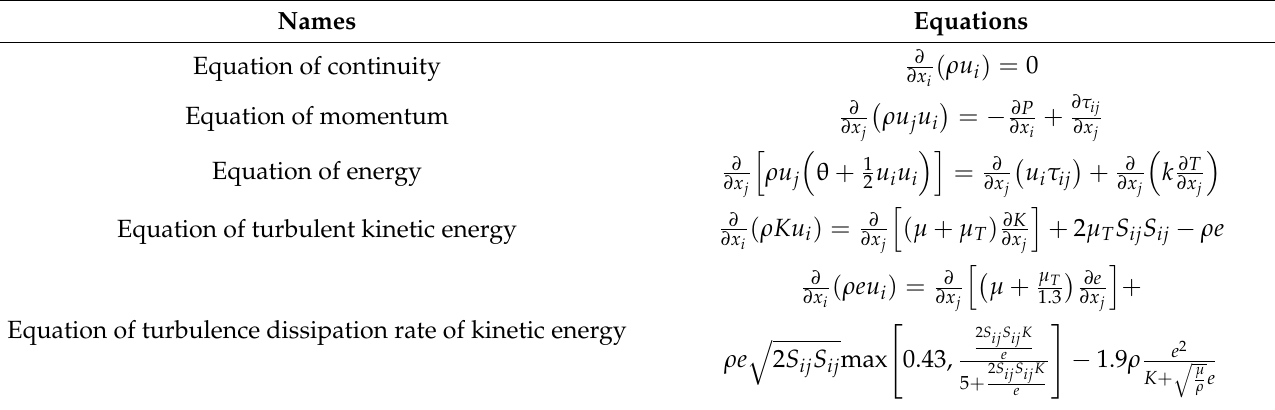
Table A2. Details of momentum and energy Realizable k- ω -realizable